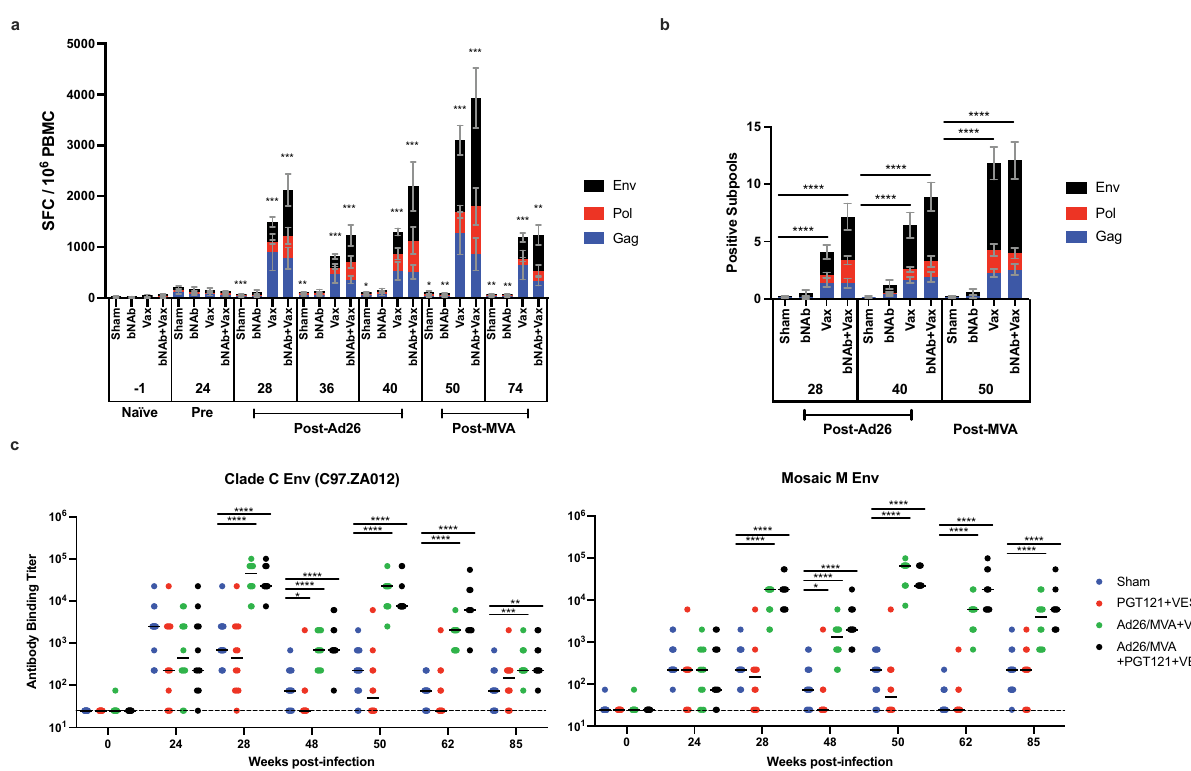
Fig. 2 Induction of immune responses to treatment interventions. a Vaccination signi fi cantly and durably increased the size of SHIV-speci fi c cellular immune IFN- γ responses over time in comparisons with pre-vaccination responses ( “ Pre ” , week 24). Mean ±standard error is shown. b Vaccination signi fi cantly increased the breadth of SHIV-speci fi c cellular immune IFN- γ responses in comparison to sham treatment. Means and standard errors are shown. c Vaccination signi fi cantly increased antibody binding to clade C and mosaic (mosaic 1) HIV-1 Env with median indicated. Two-sided Mann – Whitney tests were used to determine signi fi cance in non-paired analyses ( a , c ), and two-sided Wilcoxon matched-pairs sign rank tests were used in paired analyses ( b ). Sham = sham treatment; ‘ bNAb ’ or ‘ PGT121 + VES ’ = PGT121 + vesatolimod treatment; ‘ Vax ’ or ‘ Ad26/MVA + VES ’ = Ad26/MVA + vesatolimod treatment; and ‘ bNAb + Vax ’ or ‘ Ad26/MVA + PGT121 + VES ’ = Ad26/MVA, PGT121, + vesatolimod treatment. * p < 0.05 (in a , from left to right, p = 0.184 and 0.0339 for Sham; in c , p = 0.0465 in Clade C and 0.0489 in Mosaic M), ** p < 0.01 (in a , from left to right , p = 0.0072 and 0.0016 for Sham, 0.0024 and 0.0068 for bNAb, and 0.002 for bNAb + Vax; in c , p = 0.0013), *** p < 0.001 (in a , from left to right, p = 0.005 for Sham, 0.0005 for all Vax, and 0.001 for bNAb + Vax from weeks 28 to 50; in c , p = 0.0008), **** p <